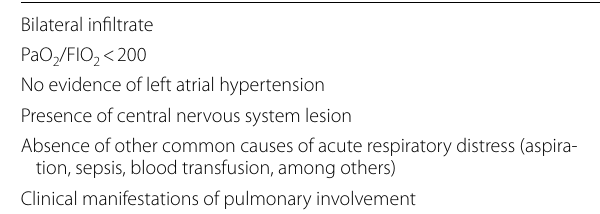
Table 2 Criteria for the diagnosis of neurogenic pulmonary edema